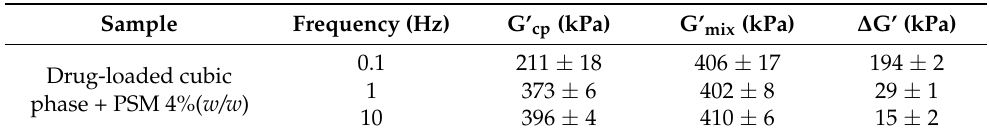
Table 1. Elastic moduli of drug-loaded cubic phase alone (G’ cp ), cubic phase/PSM mixture (G’ mix ) and calculated interaction terms ( ∆ G’) obtained from oscillatory frequency sweep analysis. The results are reported as mean values ± standard deviation.